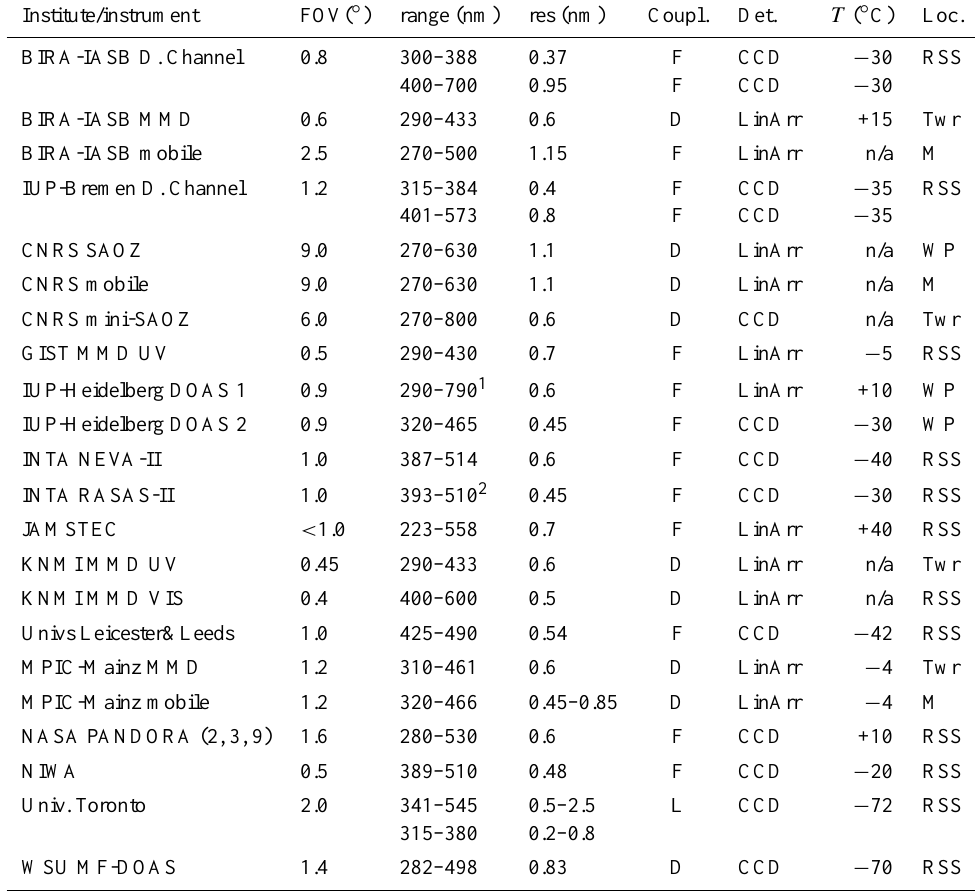
Table 1. Overview of CINDI participating spectrometers. “MMD” means Mini-MAX-DOAS (Appendix A). Columns denote: institute, field of view, spectral range and spectral resolution, coupling between telescope and spectrometer (F: multimode fibre, D: direct coupling, L: liquid light guide), type of detector, detector temperature and site location (RSS: remote sensing site, Twr: tower, WP: wind profiler site, M: mobile). Other details are given in Appendix